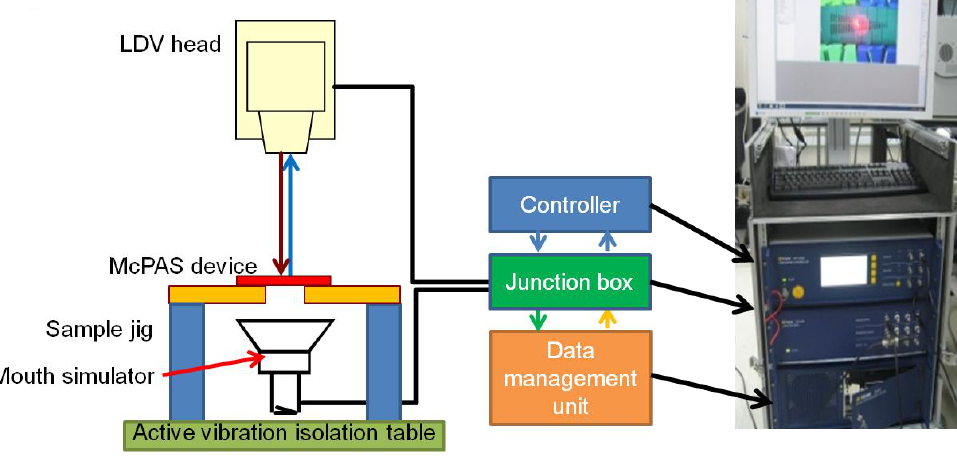
Figure 6. Schematic of experimental setup for vibratory property measurement of McPAS and picture of LDV controller system.